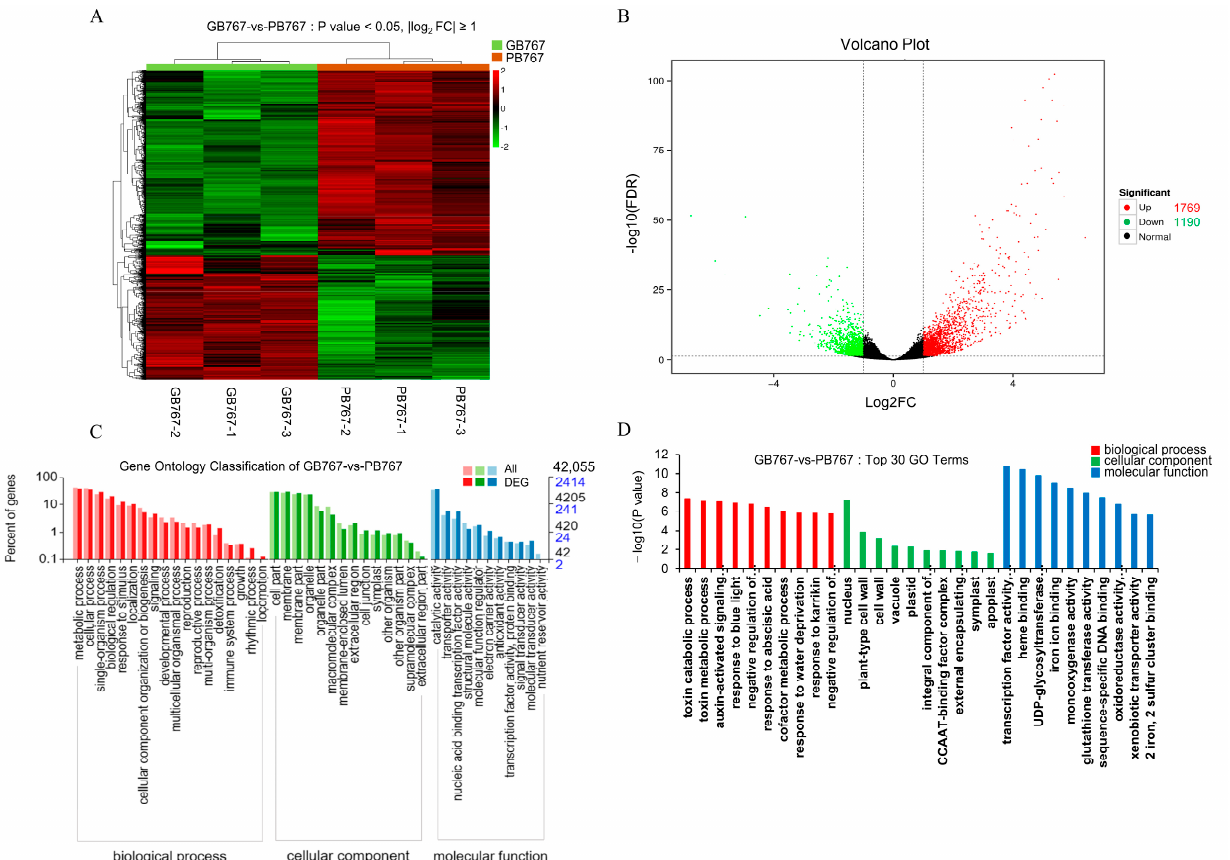
Figure 2. Identification and GO functional enrichment analysis of DEGs in GB767 vs. PB767. ( A ) Heatmap and hierarchical clustering of DEGs. ( B ) Volcano plot showing the number of upregulated and downregulated genes. ( C ) Comparison of the distribution of DEGs and all expressed genes at GO level 2. ( D ) Top 30 terms of GO functional enrichment analysis.